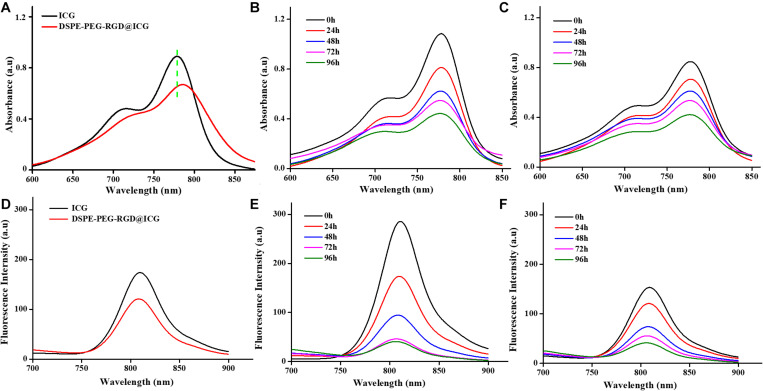
UV–vis absorption spectra (A) and fluorescence emission spectra (D) of free ICG and DSPE-PEG-RGD@ICG. Stability assessment of free ICG (B, E) and DSPE-PEG-RGD@ICG (C, F) for 4 days.